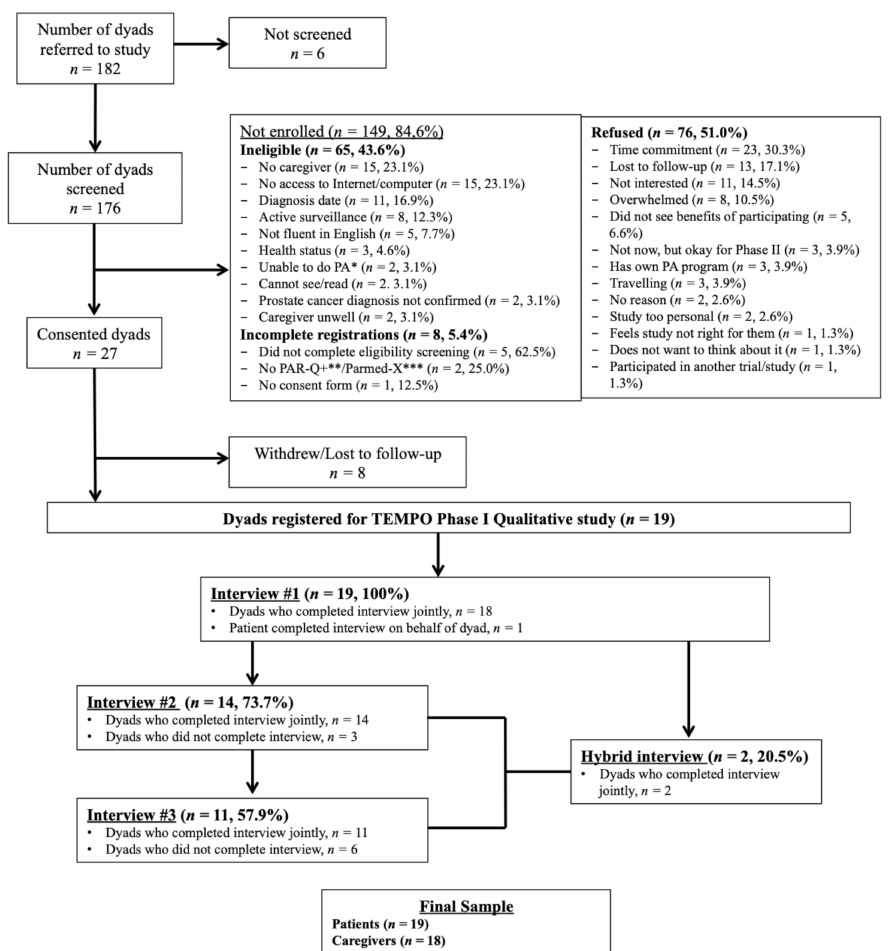
Figure 1. Flow diagram of a participant’s involvement in the qualitative assessment of TEMPO for dyads facing prostate cancer. Note: * Physical Activity (PA); ** Physical Activity Readiness Questionnaire for Everyone (PAR-Q + ); *** Physical Activity Readiness Medical Examination